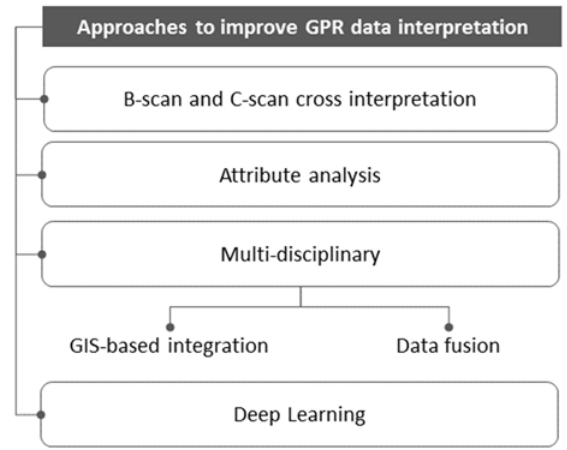
Figure 1. Overview of the reviewed approaches to improve GPR data interpretation from archaeo- logical prospection.